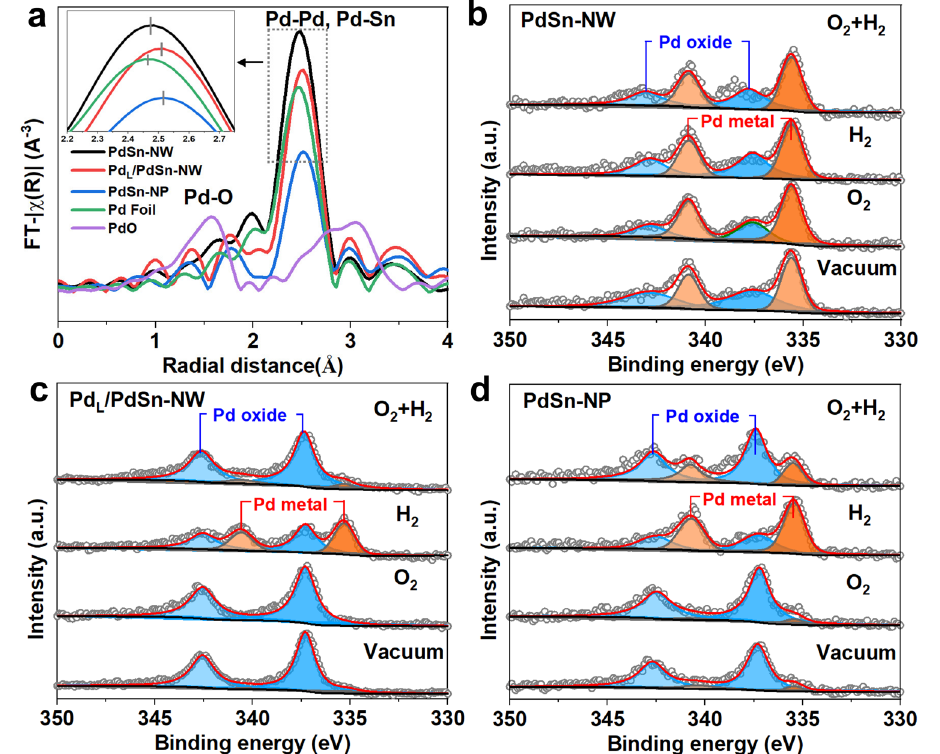
Fig.4|EXAFSspectraofthePdKedgeofPdSncatalystsandreferencesamples, and NAP-XPS of Pd 3 d spectra for PdSn catalysts under different treatment conditions. a EXAFS spectra of the PdK edge of PdSn catalysts after annealing in air. b In situ NAP-XPS of Pd 3 d spectra for PdSn-NW in the presence of O 2 , H 2 , and